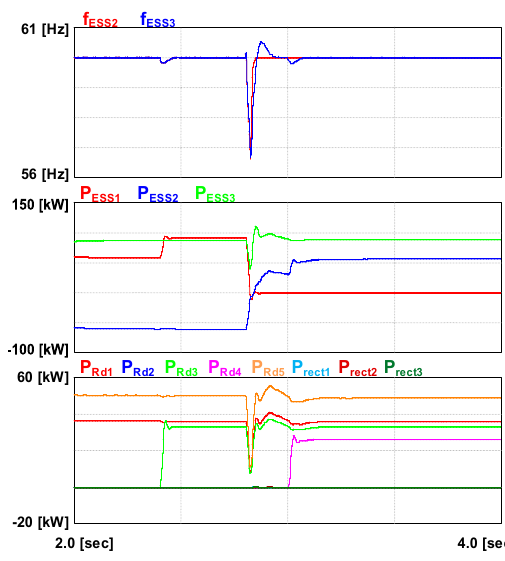
Figure 13. Simulation result—case 10.